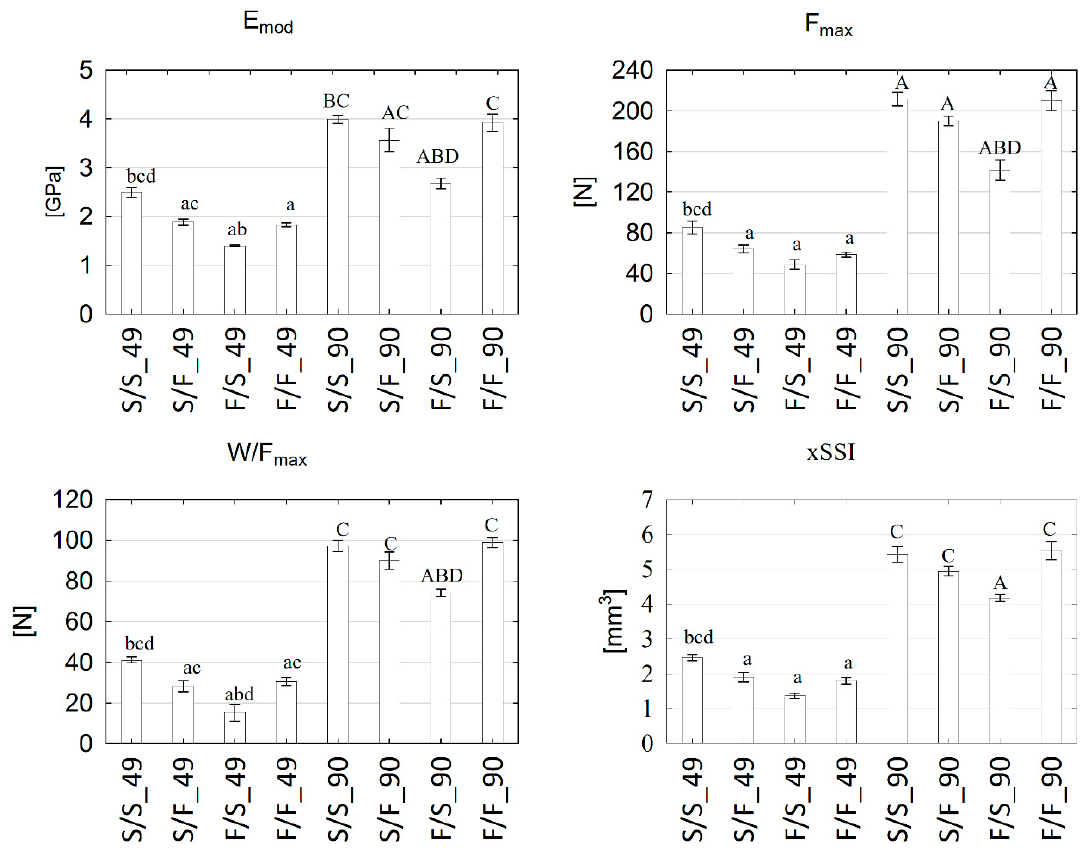
Figure 2. The mechanical parameters of the femur of male rats on the 49 and 90 days of age. Explanations: results are the means ± SEM ( n = 8). a vs. S/S_49; b vs. S/F_49; c vs. F/S_49; d vs. F/F_49; A vs. S/S_90; B vs. S/F_90; C vs. F/S_90; D vs. F/F_90.